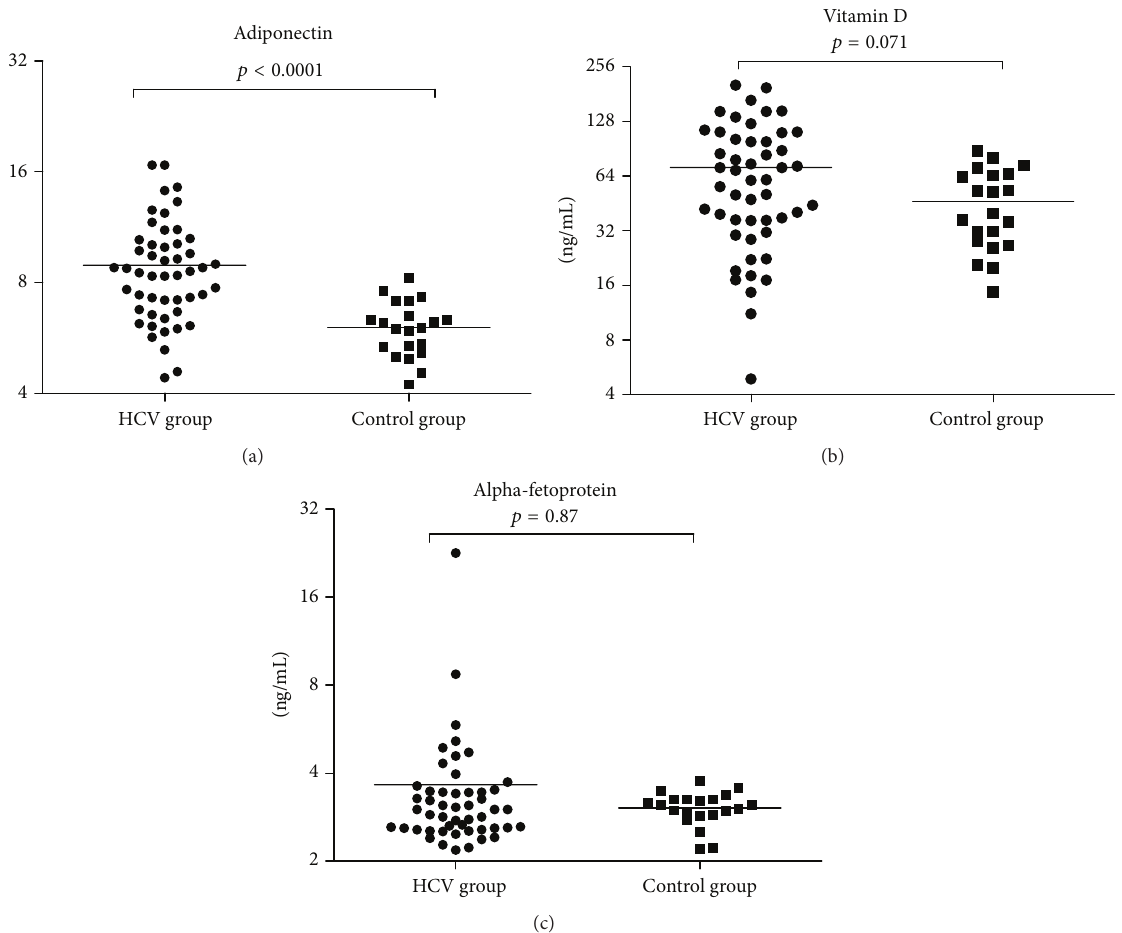
Figure 1: Comparison of pretreatment factors between HCV group and control group. (a) Adiponectin was significantly ( 𝑝 < 0.0001 ) higher in HCV group ( 8.92±2.85 ng/mL, range; 4.4–16.7 ng/mL) than control group ( 6.049±1.04 ng/mL, range; 4.2–8.2 ng/mL). (b) Vitamin D was insignificantly ( 𝑝 = 0.071 ) higher in HCV group ( 71.6 ± 49.1 ng/mL, range; 4.87–202 ng/mL) than control group ( 46.4 ± 21.8 ng/mL, range; 14.7–88 ng/mL). (c) AFP was insignificantly ( 𝑝 = 0.87 ) higher in HCV group ( 3.6 ± 2.96 ng/mL, range; 2.18–22.6 ng/mL) than control group ( 3.0 ± 0.39 ng/mL, range; 2.2–3.7